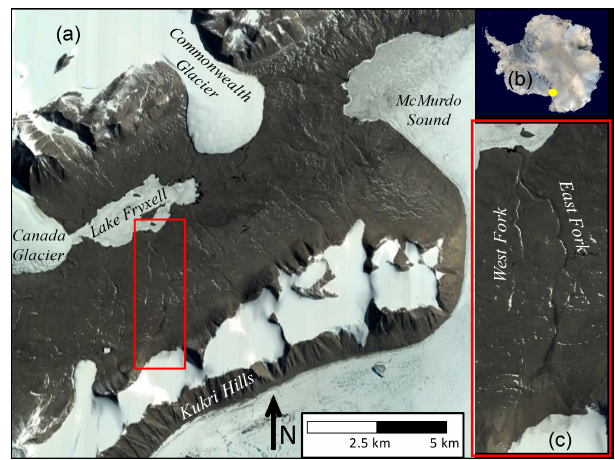
Figure 1. Map of (a) the location of the McMurdo Dry Valleys in Antarctica, (b) the Lake Fryxell basin, in the eastern portion of Tay- lor Valley, with a red rectangle indicating Crescent Stream, and (c) a zoomed in view of the East and West Forks of the Crescent